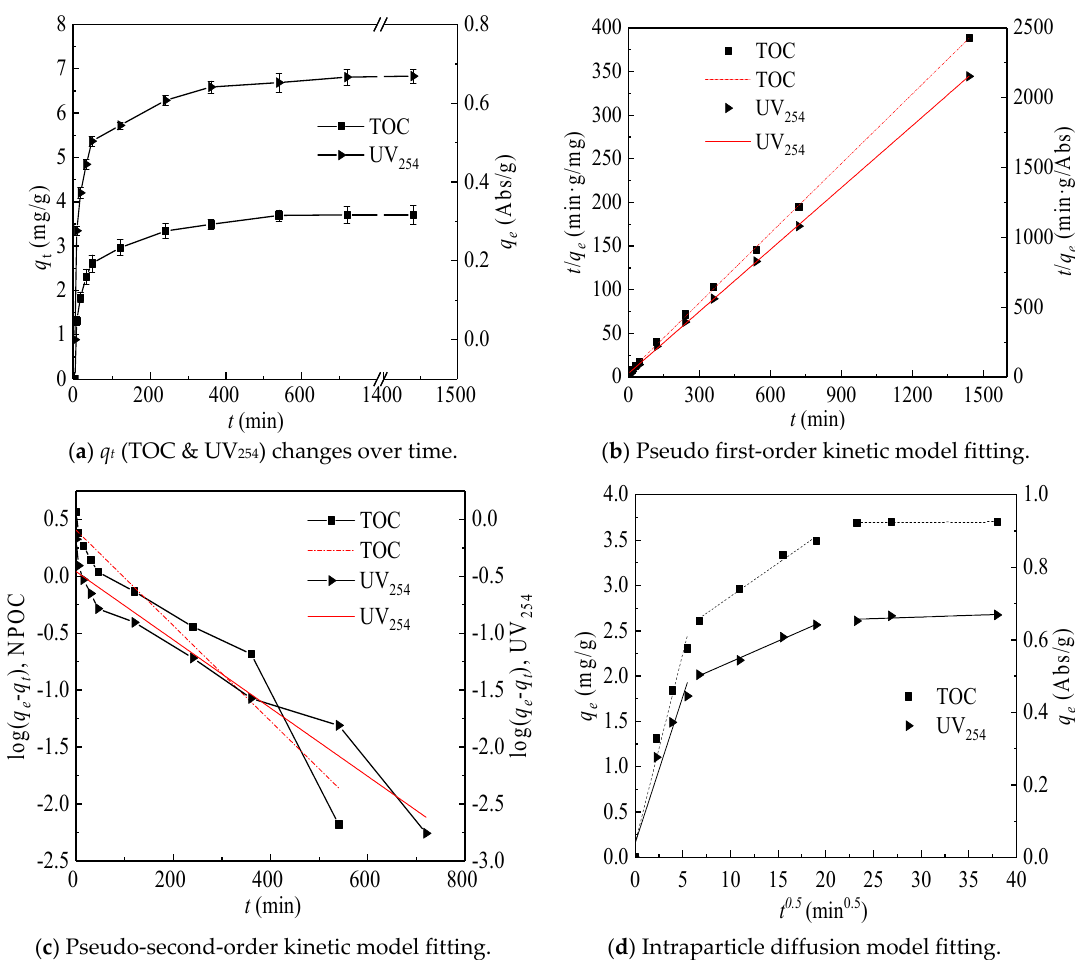
( d ) Intraparticle diffusion model fitting. Figure 7. q t (TOC & UV 254 ) changes over time and kinetics model Figure 7 . q t (TOC & UV 254 ) changes over time and kinetics model fitting. Table 4. Kinetic parameter fittings using the pseudo-first-order kinetic model and pseudo-second- order kinetic models.